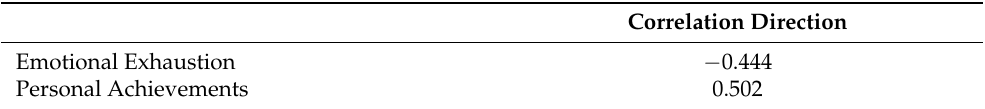
Table 9. Correlation direction from linear regression of statistically significant